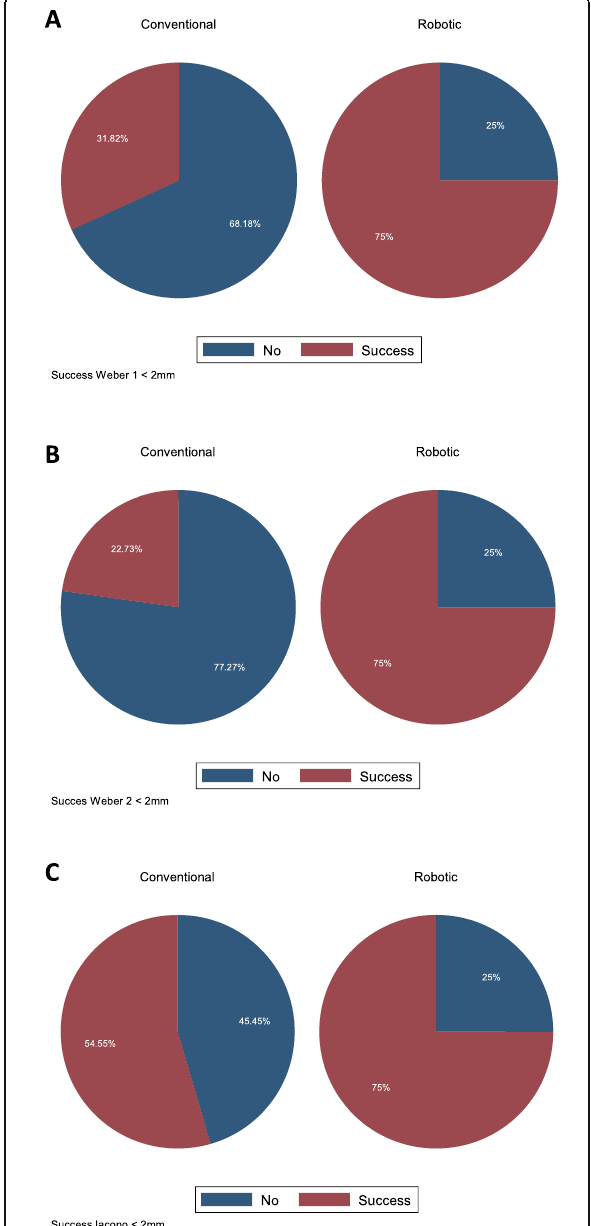
Fig. 5 Graph pie showing the proportion of patient that achieve the position of the femoral component two millimeters or below to the femoral joint line by type of UKA according to Weber 1 method ( a ) Weber 2 method ( b ) and Iacono method ( c )